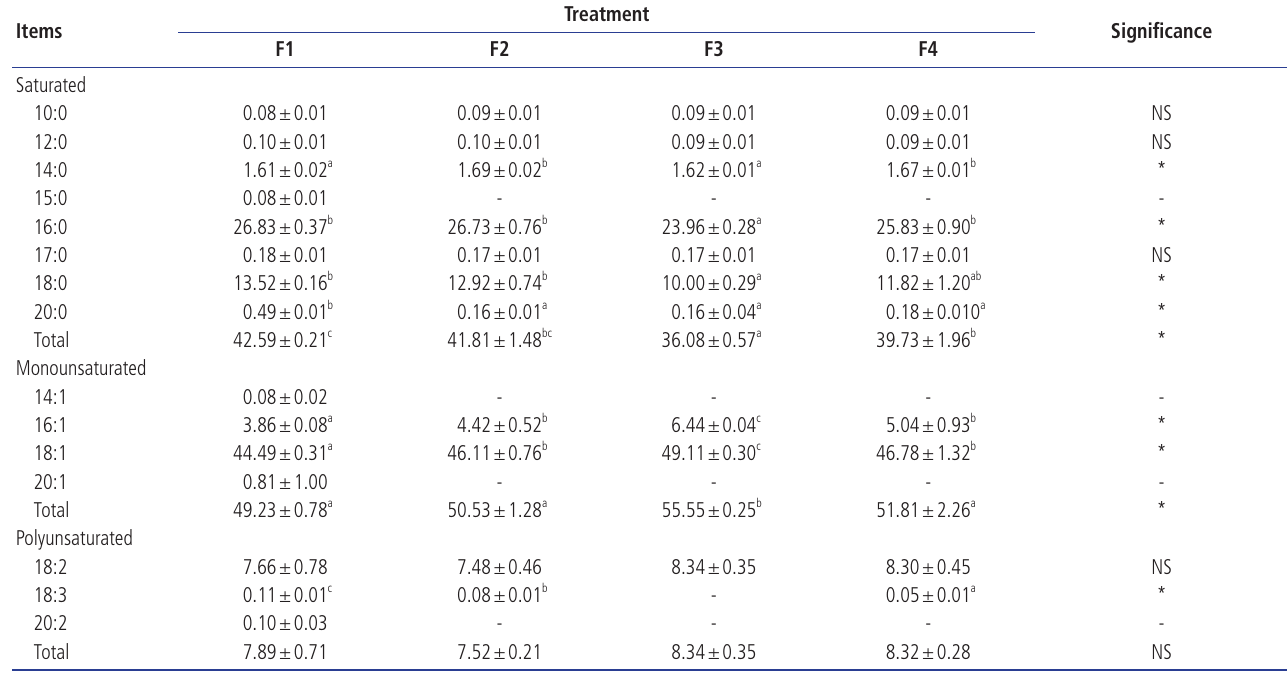
Table 4. Fatty acid profile of fermented venison sausage (%) (mean values±standard error of the